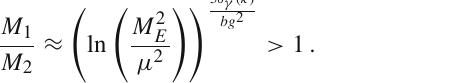
Fig. 6 Coupled SDE system of two fermions, indicated by 1 = U and 2 = D , considering also the electromagnetic interaction (3rd